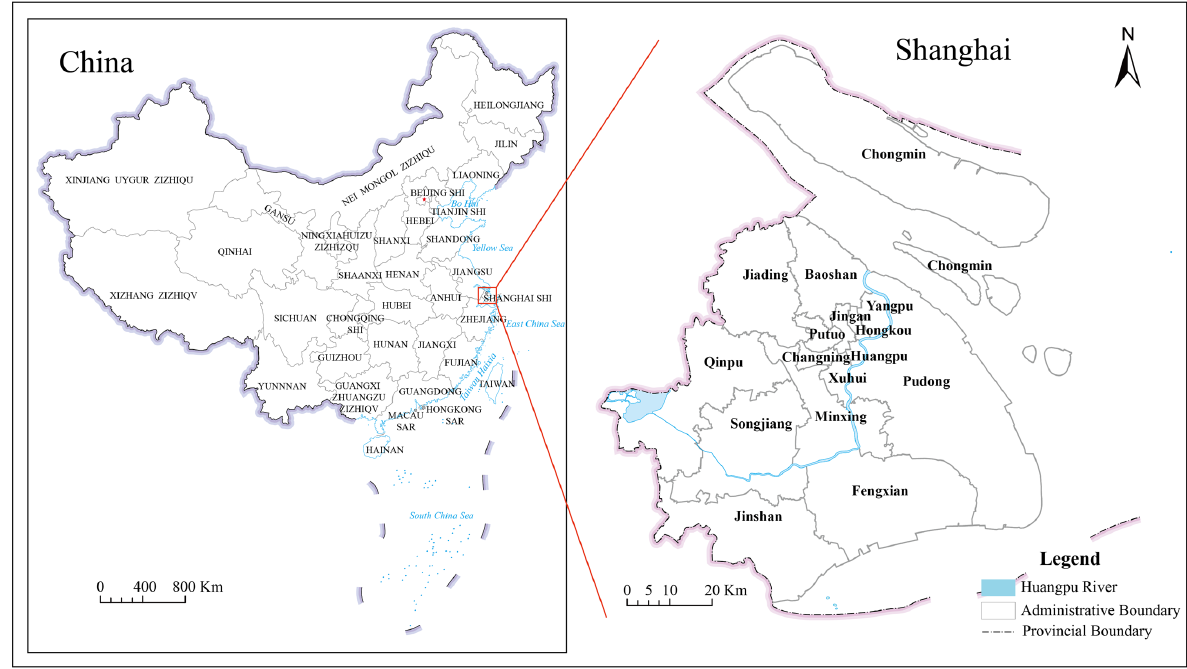
Figure 2. Overview of the study area. Table 1. Hierarchical control requirements for emergency shelters in Shanghai.